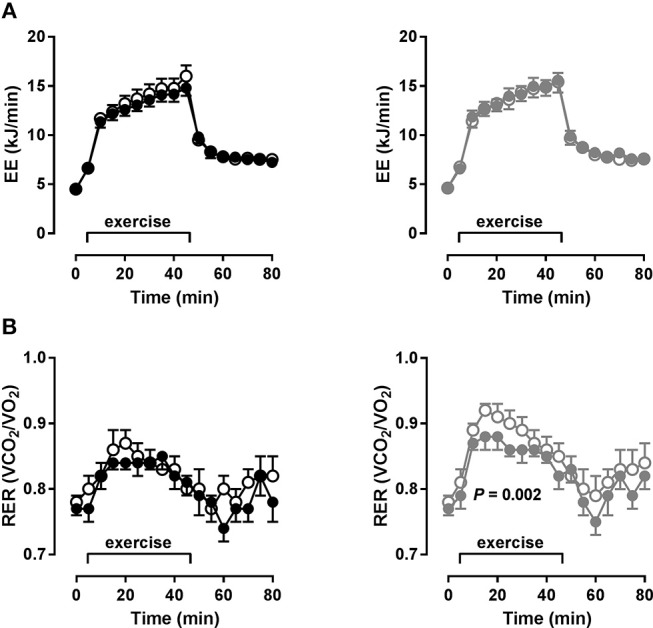
Systemic energy metabolism during exercise (metabolic chamber). (A) Energy expenditure (EE) and (B) respiratory exchange ratio (RER) at rest and during bicycle exercise after glucose in MS patients before (open circles) and after (closed circles) 4 weeks of normoxic (NO, n = 16, black circles) and hypoxic (HO, n = 17, gray circles) treadmill training. Data as mean (SEM), P-value (training) by ANOVA.